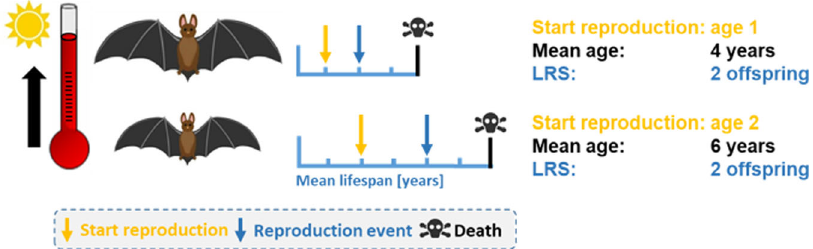
Fig. 6 Graphical summary of the interplay between global warming, life-history traits and lifetime reproductive success. With higher temperatures bats grow larger and compensate for their higher mortality with a faster pace of life.